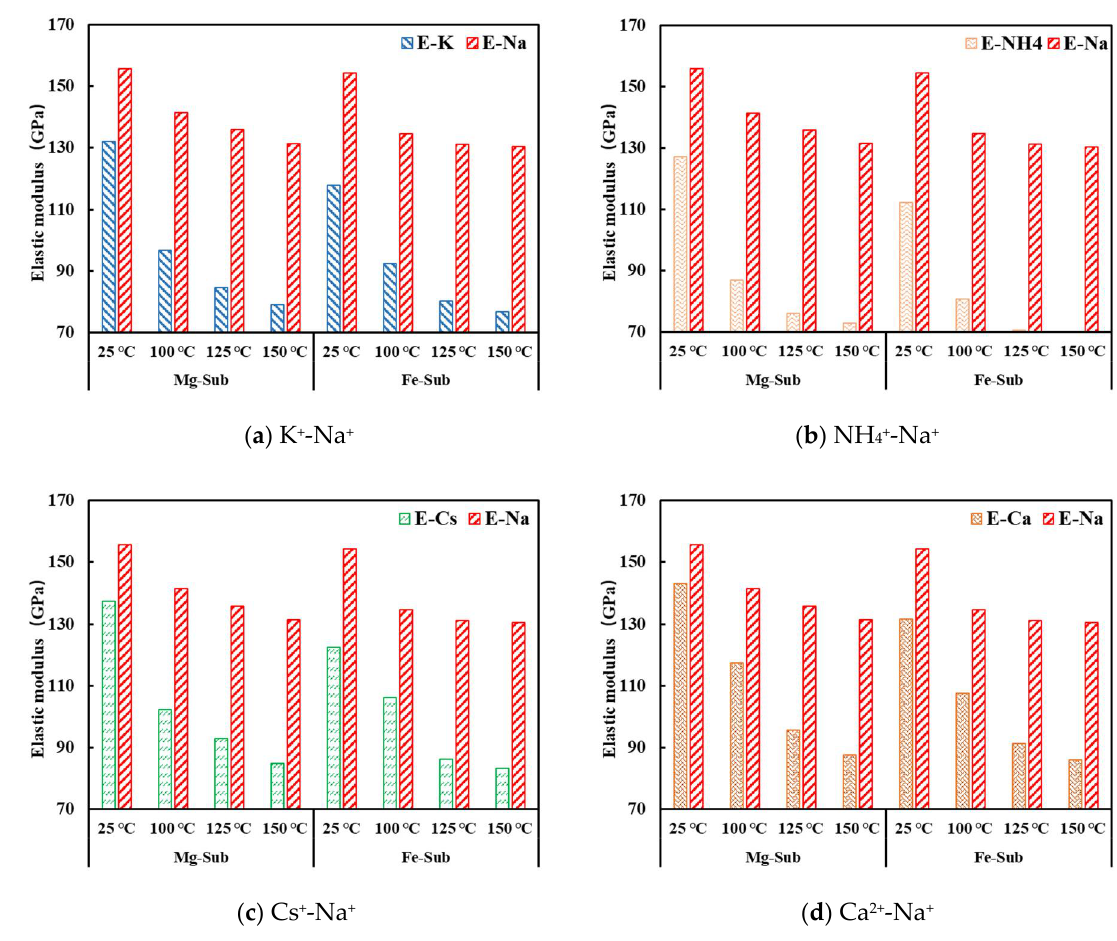
Figure 9. Elastic modulus of MMT crystals under different temperatures and inhibiting cations.